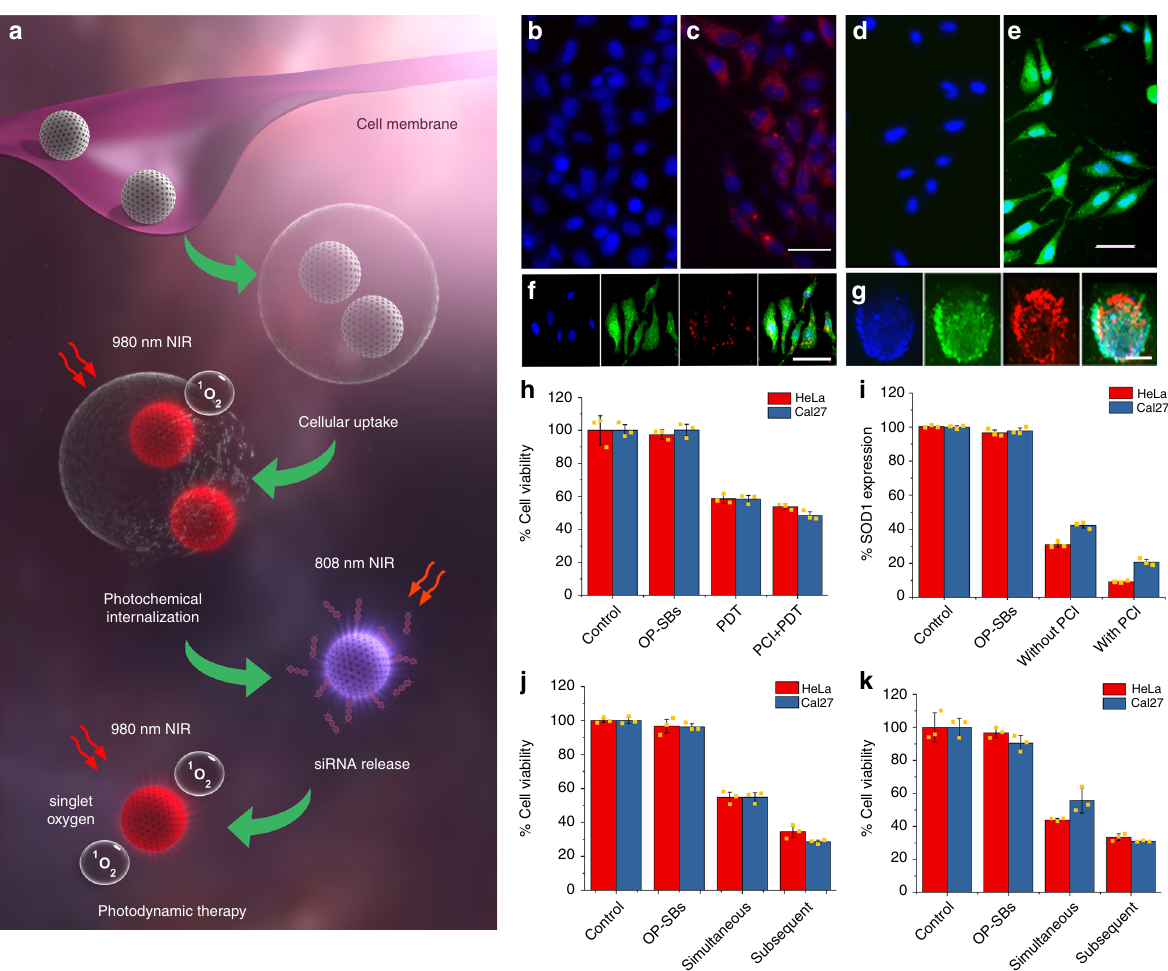
Fig. 3 Programmed orthogonal photoactivation. a Schematic illustration of orthogonal excitation of photosensitizers and azobenzene-based caps for endosomal escape, siRNA release and photodynamic therapy. b , c Cells without and with siRNA loaded OP-SBs and irradiated with 808 nm NIR for siRNA release, scale bar is 50 μ m. d Production of singlet oxygen in cells with NIR irradiation in comparison to non-irradiated cells ( e ), scale bar is 50 μ m. f , g Uptake of OP-SBs@azo-Psi in 2D culture cells (scale bar is 50 μ m) and 3D tumor spheroids (scale bar is 200 μ m). h Comparison of HeLa and Cal27 cell killing by OP-SBs@azo-Psi based PDT without and with PCI. i Comparison of SOD1 gene expression without and with PCI. j , k Comparison of simultaneous (non-orthogonal) and subsequent (orthogonal) activation of endosomal escape, siRNA release and PDT and their effects on cell viability of HeLa and Cal27 2D culture and 3D tumor spheroids. Error bars represent the standard deviation of measurements from three ( n = 3) distinct